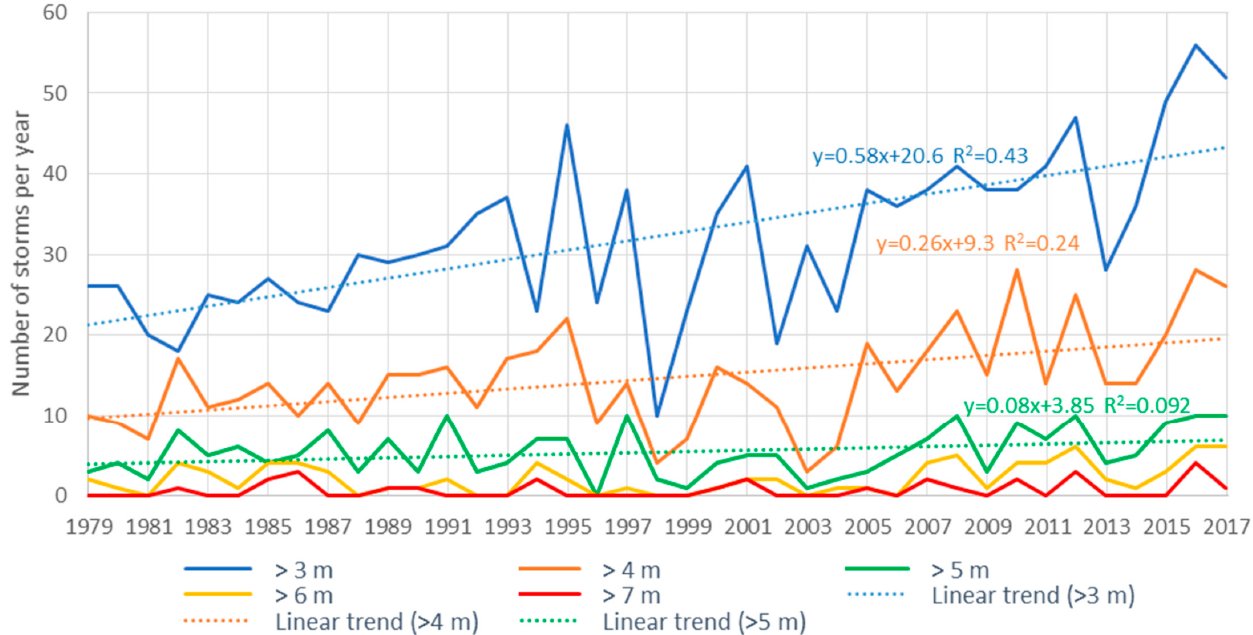
Figure 10. The number of storms with different SWH thresholds per year and its linear trends for 1979 to